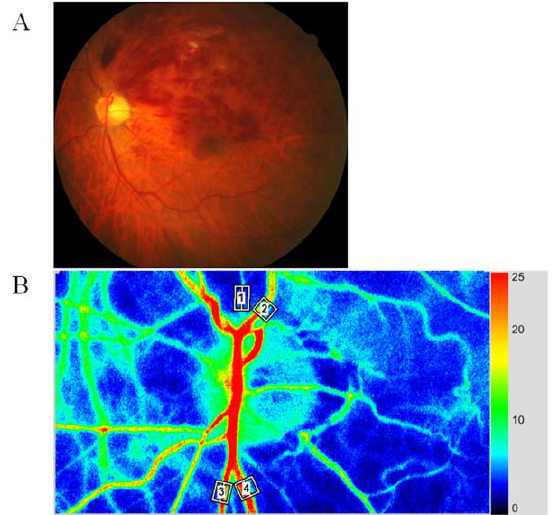
Figure 1. Representative fundus color photograph, and representative relative blood volume data obtained with laser speckle flowgraphy (LSFG). ( A ) Fundus color photograph shows branch retinal vein occlusion (BRVO). The upper part is the occluded region, and the lower part is the non-occluded region. ( B ) Blood flow was automatically tracked in an artery (white square #1) and vein (white square #2) in the occluded region and in an artery (white square #3) and vein (white square #4) in the non-occluded region.